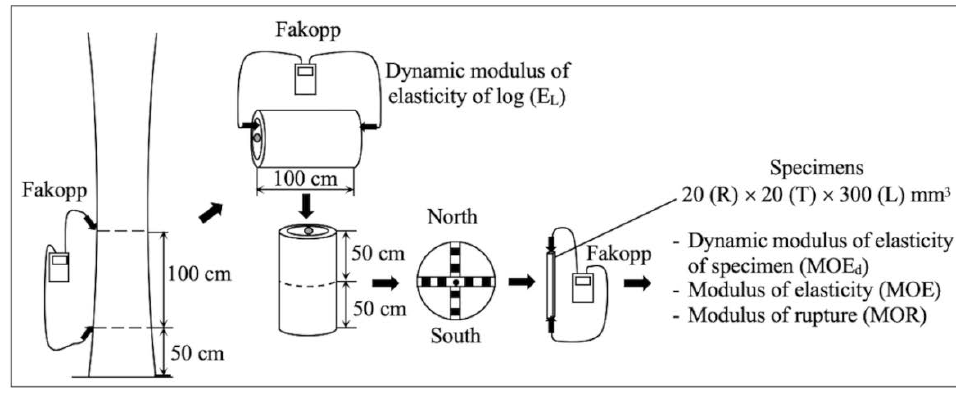
Figure 1. Illustration of experimental procedures.